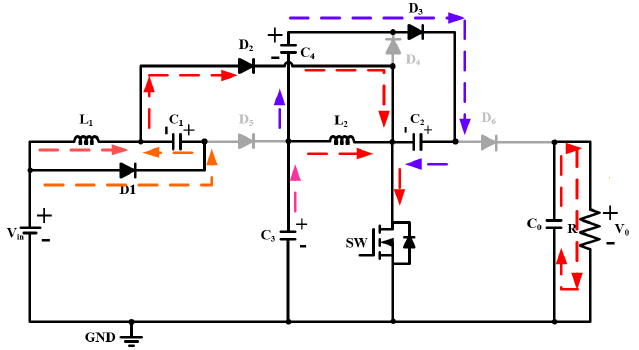
Figure 6. Circuit configuration during the first mode of operation.